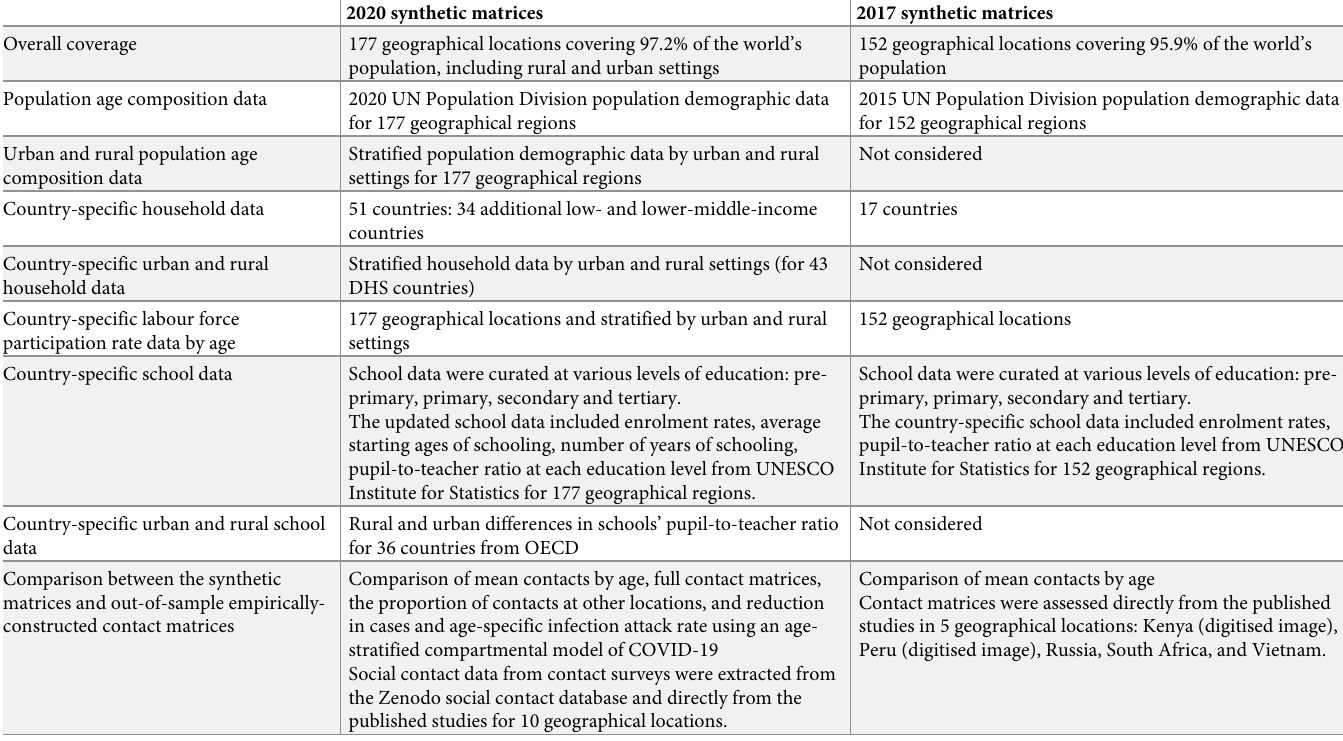
Table 1. Summary of the changes between the 2017 and 2020 synthetic